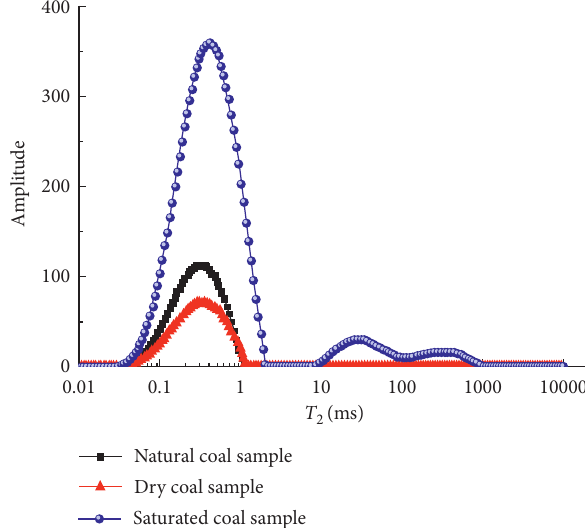
Figure 4: T 2 distribution of vertical bedding at different water conditions of Yuwu, Shanxi.